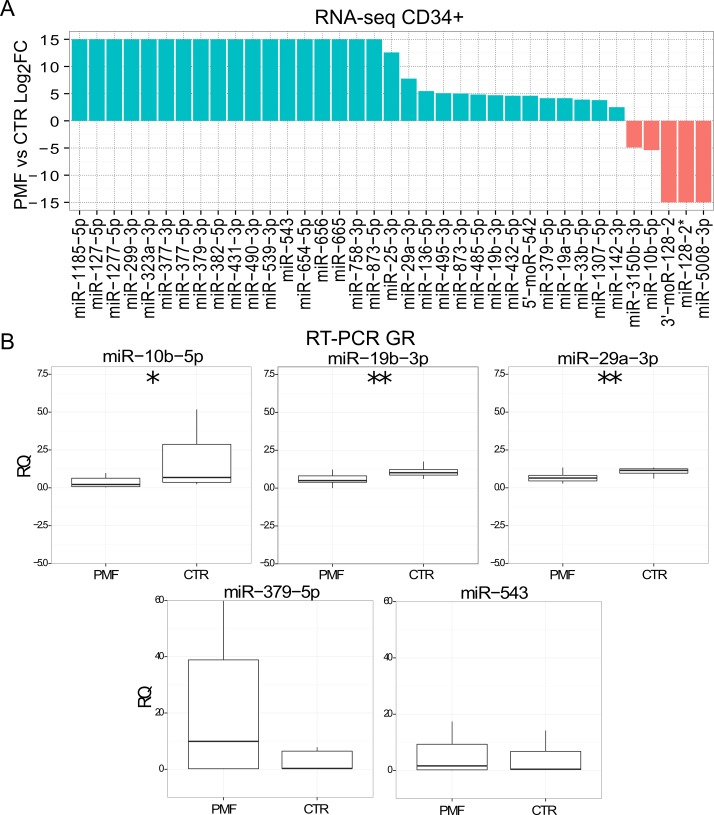
Differential expression of small RNAs in PMF vs CTR CD34+.A) Log2 FC of 37 small RNA differentially expressed considering PMF vs CTR CD34+, according to RNA-seq data (FDR<0.05). When a small RNA was not expressed in one sample category, the ratio was infinite and we represent it as the arbitrary maximum value of 15. B) RT-PCR expression calculation of five selected miRNAs in granulocytes collected from an independent cohort of normal controls (n = 10) and of PMF (50) samples; ***, ** and * indicate respectively a p-value <0.001, <0.01 or <0.05.